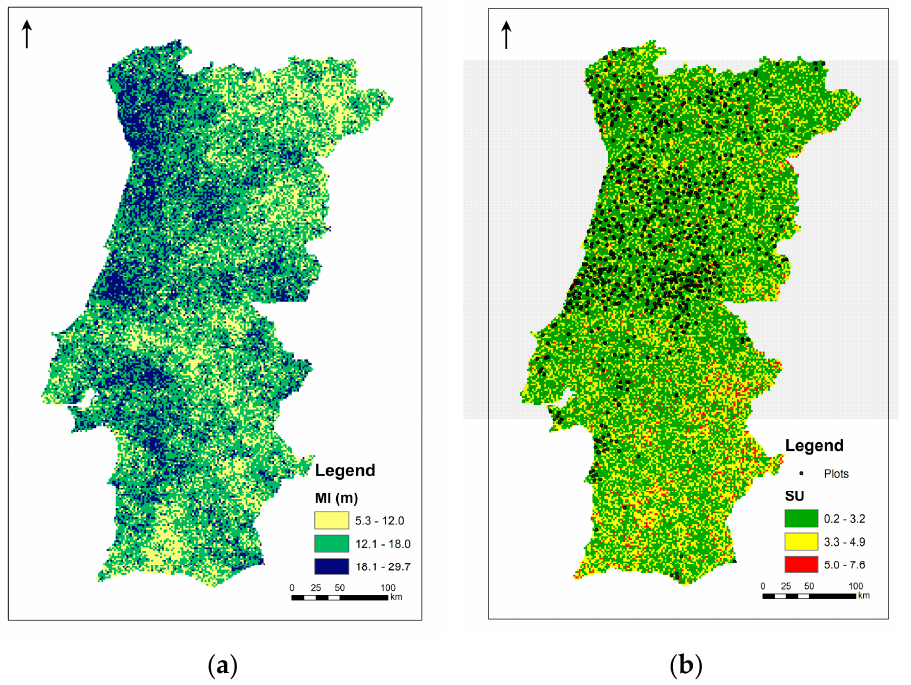
Figure 6. Maritime pine forest productivities by back-transformed sequential Gaussian simulation. ( a ) Site index map — SI 35 mean image (MI), and ( b ) back-transformed standard deviation ( SU ). Legend: SI 30 —stand dominant height (m) at the age of 35 years; MI —mean image of 100 computed scenarios through back-transformed SGS (sequential Gaussian simulation); SU —spatial uncertainty (back-transformed standard deviation).